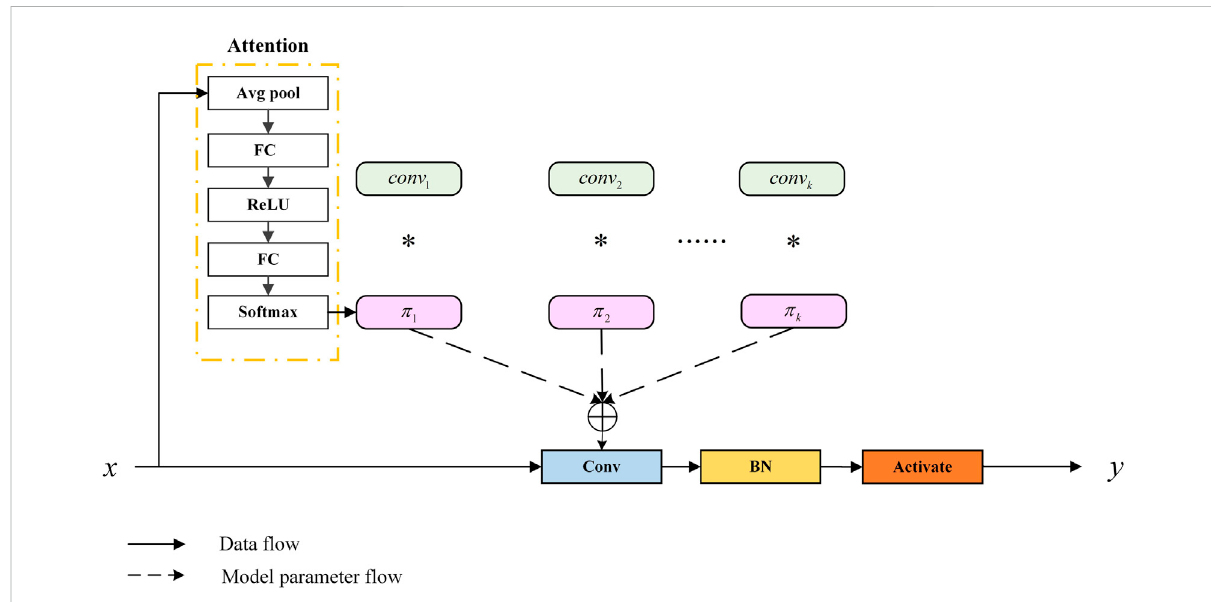
FIGURE 5 Schematic of the dynamic convolution module (Chen et al.,